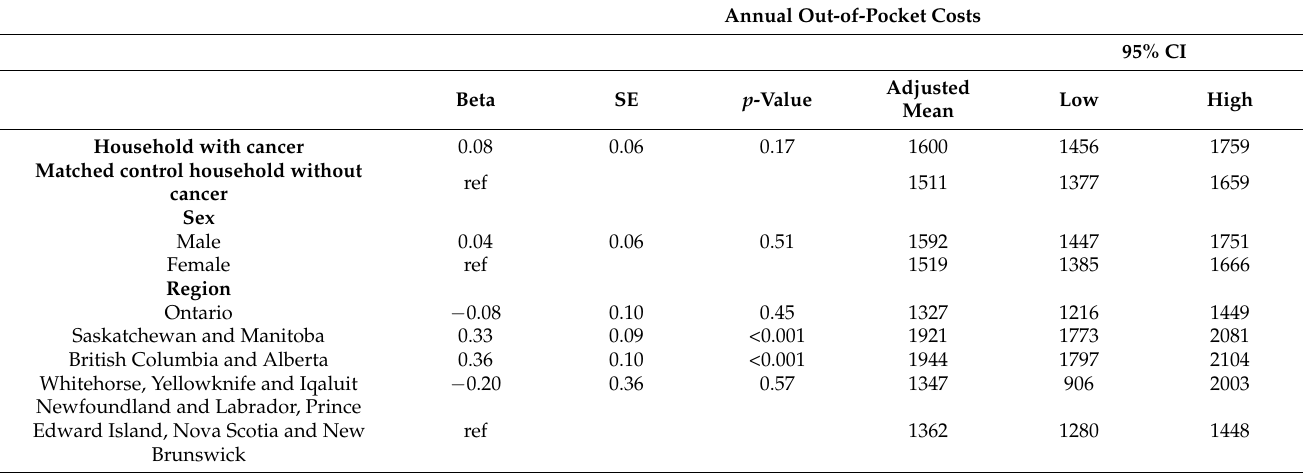
Table 7. Model-adjusted out-of-pocket expenditures for households with cancer and without